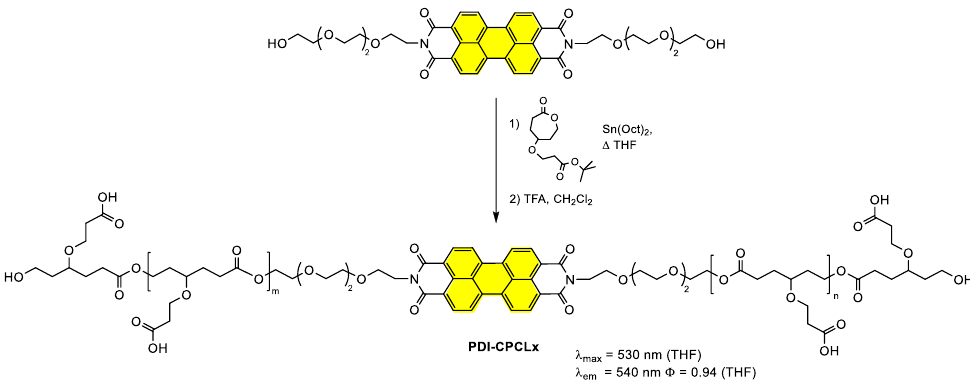
Figure 7. Synthesis of PDI-PMA polymer; fluorescence spectra of PDI-PMA in water; fluorescence spectra of the copolymer PDI-PMA in the buffers with various pH values (C = 1.25 mg·mL − 1 ) with λ exc = 488 nm. Reprinted with permission from reference [104].